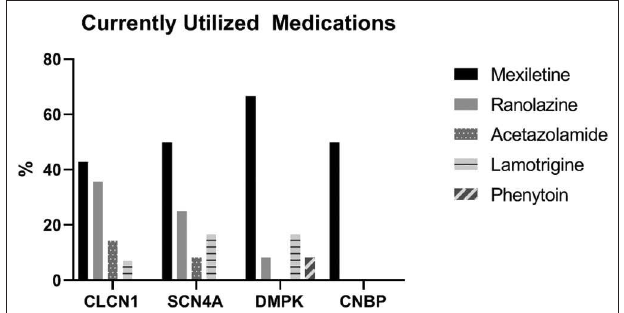
FIGURE 3 | Proportion of individuals, by genotype, who had ever trialed an antimyotonia medication and who were currently taking one at the time of chart review.